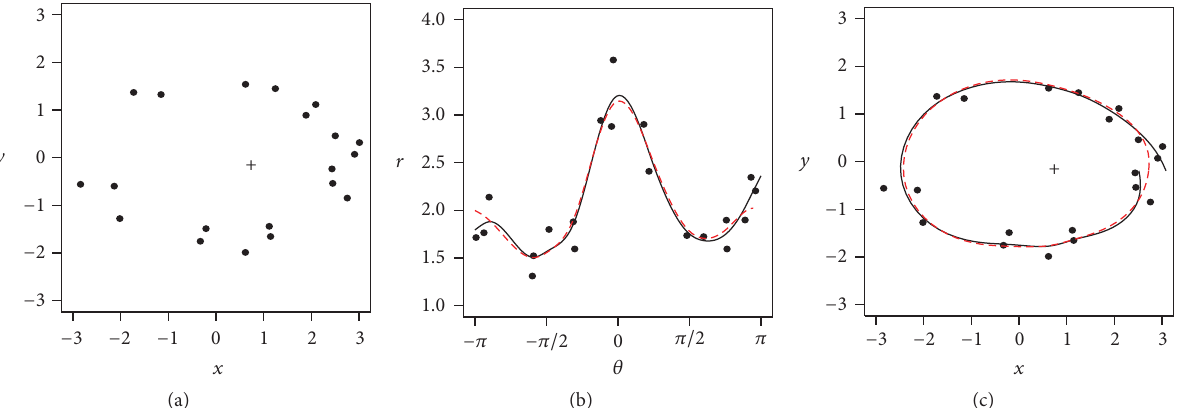
Figure 5: (a) Simulated data; (b) polar coordinate data with fitted spline curve; (c) data with back-transformed fitted curves. In (b) and (c) the solid curves use standard splines, whereas the dashed use the periodic spline.